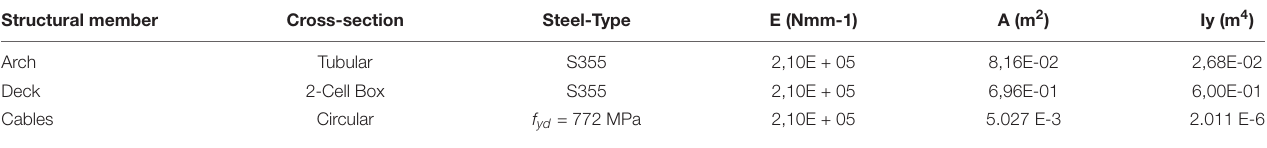
FIGURE 3 | Transverse section of the bridge (unit: cm). TABLE 2 | Mechanical properties of the employed finite element model of the bridge. Structural